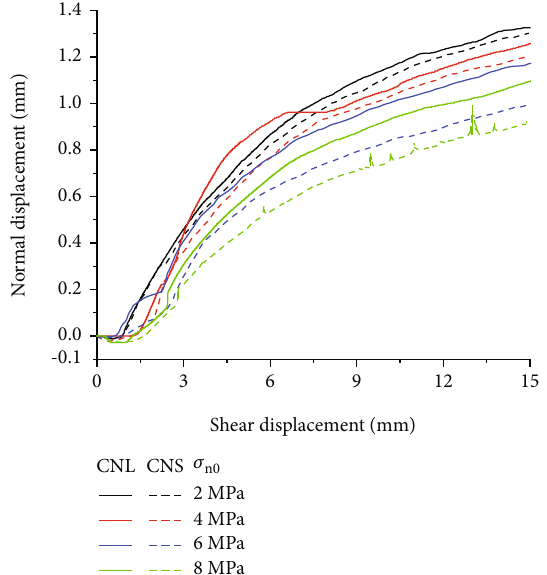
Figure 8: Curves of normal displacement with shear displacement.